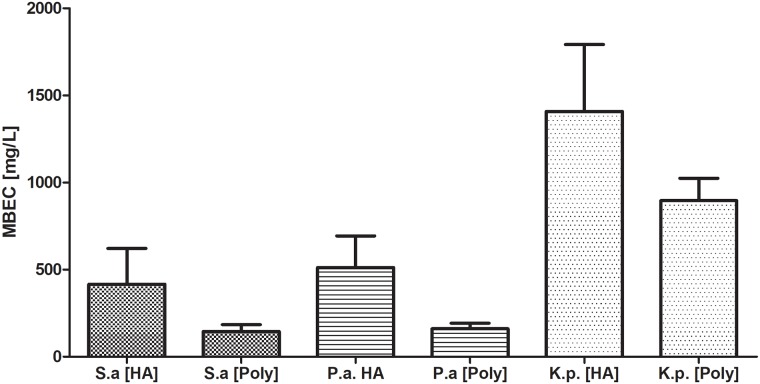
Comparison of Minimal Biofilm Eradication Concentration [MBEC] of gentamicin against biofilm formed on hydroxyapatite [HA] or polystyrene [Poly] surfaces by P.aeruginosa [P.a], S.aureus [S.a.], K.pneumoniae [K.p.] in 24-well plates.